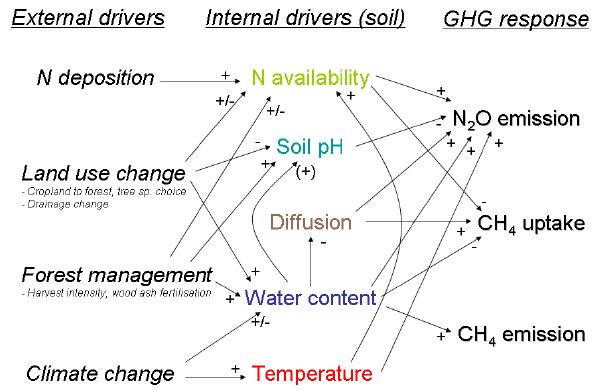
Fig. 6. Synthesis of the effects and interactions of forest change on GHG exchange observed in this study. Arrows starting from the external drivers denote those positive or negative impacts on inter- nal drivers comprised in our study. The + or − signs at the arrows starting from an internal driver indicate the observed direction (in- crease or decrease) of the effect on GHG exchange (or the interac- tion on another internal driver) when the internal driver in question